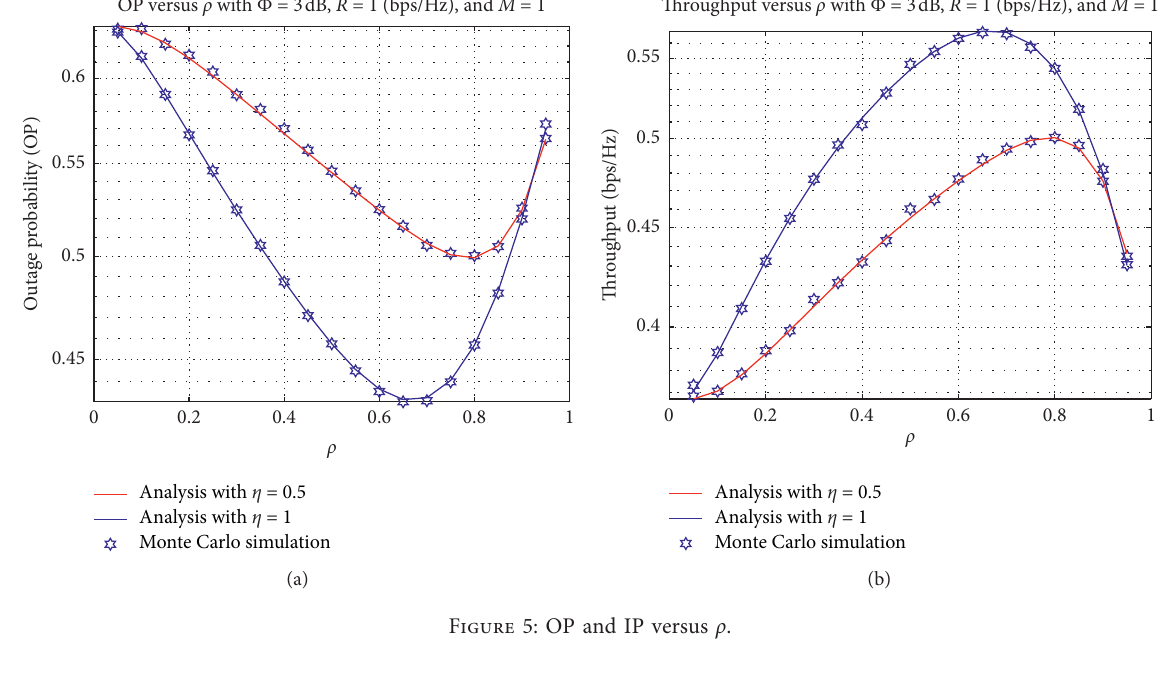
Figure 5: OP and IP versus ρ .